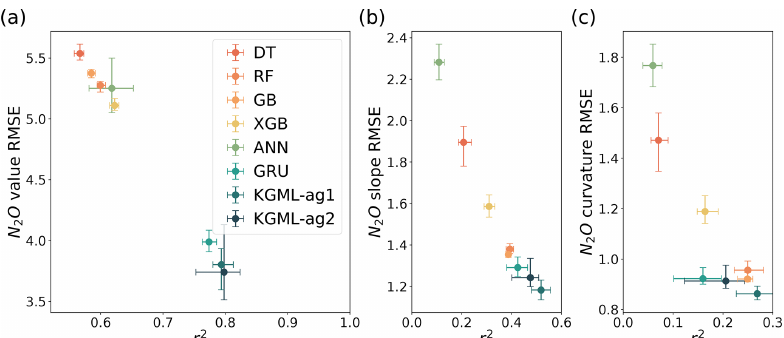
Figure 4. The comparisons of overall prediction accuracy from leave-one-out cross validation for N 2 O value (a) , first-order gradient ( slope, b) and second-order gradient ( curvature, c) between four tree-based ML models (DT, RF, GB and XGB), two deep-learning models (ANN and GRU) and KGML-ag models. The overall performance was calculated by comparing out-of-sample predictions (each chamber’s predictions were from models trained by other five chambers) from all validated chambers with observations. Different color symbols represent the different models. The x - and y -error bars are coming from the maximum and minimum scores of ensemble experiments. The dot represents the mean score of the ensemble